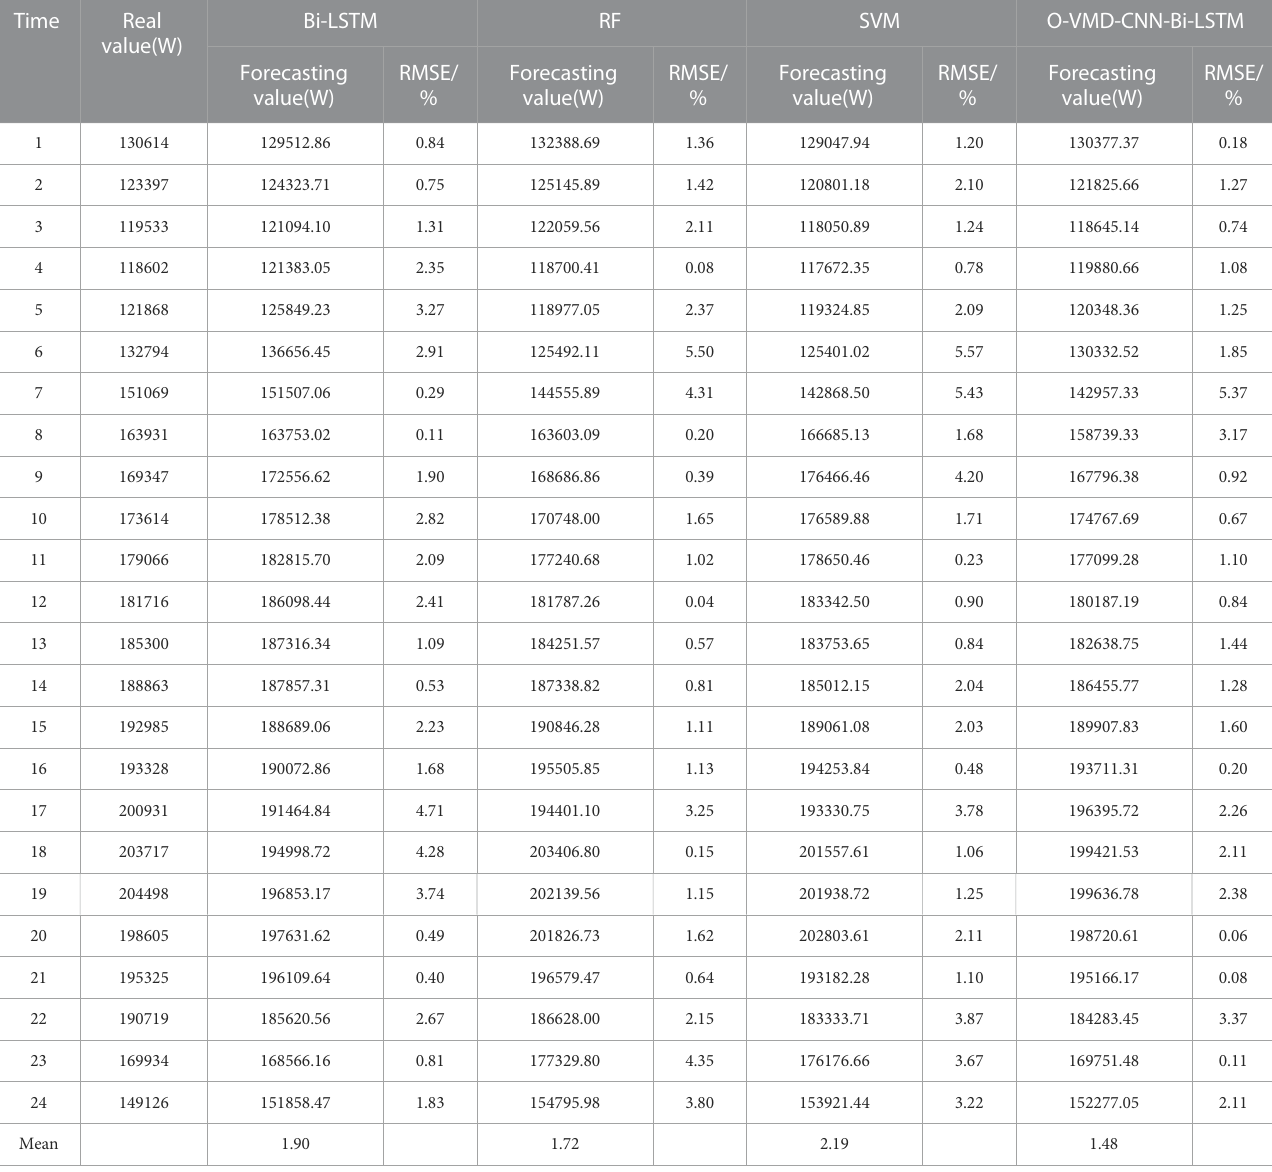
TABLE 3 Statistical results of load forecasting of different models on a certain